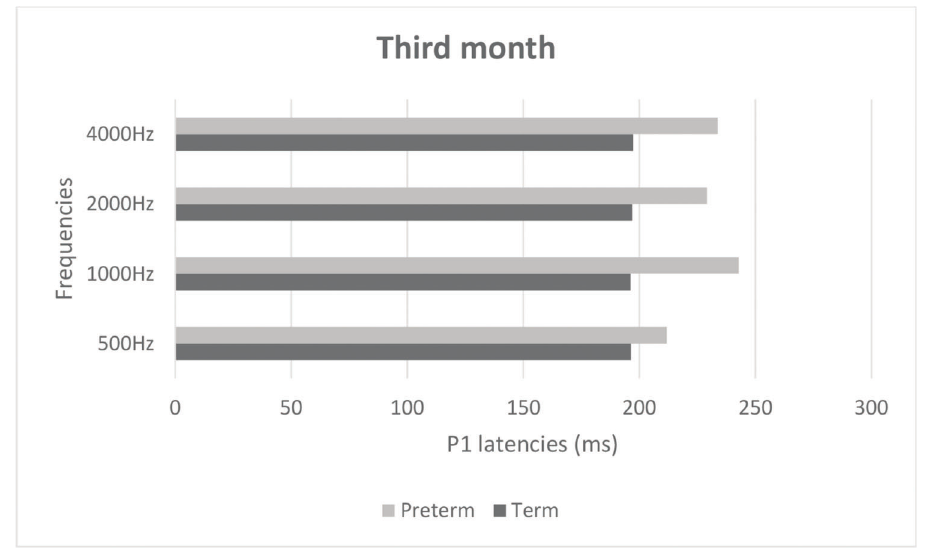
Figure 3 - P1 latency values in term and preterm infants in the third month of